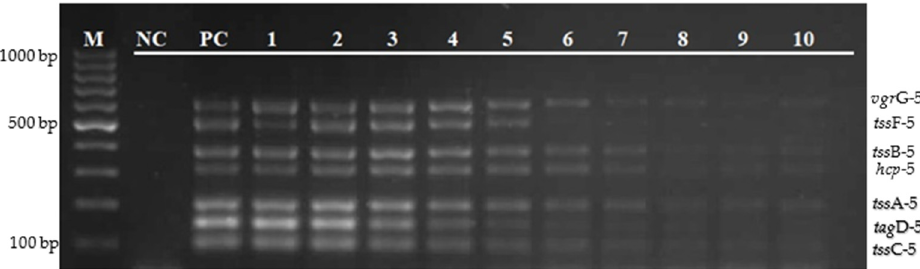
Figure 5. Analytical sensitivity of multiplex PCR assay in the presence of 10 9 to 10 0 CFU/mL of B. pseudomallei concentrations. Lane M: 100 bp DNA ladder; lane NC: negative control; lane PC: positive control; and lanes 1–10 represent 10 9 to 10 0 CFU/mL lysate of B. pseudomallei , respectively.